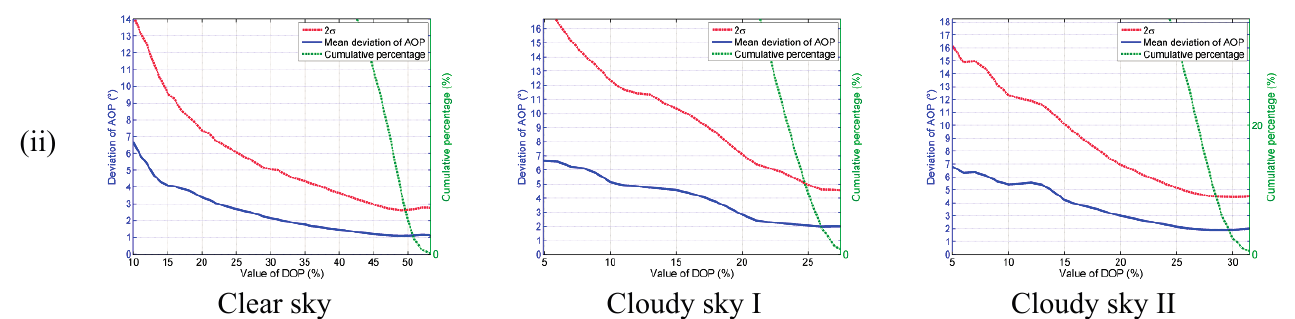
Figure 9. The relationships between deviations of AOP and the values of DOP (row (ii) is the drawing of partial enlargement of row (i) in the red